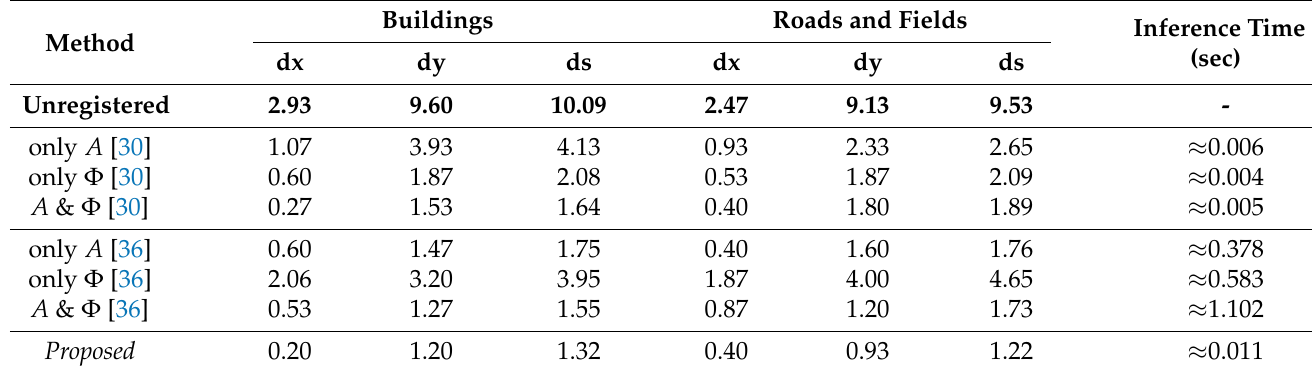
Table 3. Quantitative evaluation on the ISPRS Ikonos dataset. Errors measured as average euclidean distances between 15 landmark locations. dx and dy represent the distances along the x and y axis, respectively. ds indicates the average error along all axes per pixel, while the last column indicates the time needed by the methods to register a pair of 192 × 192 images. Errors on building landmark locations ( left ) and errors related to points on roads and fields ( right ) are